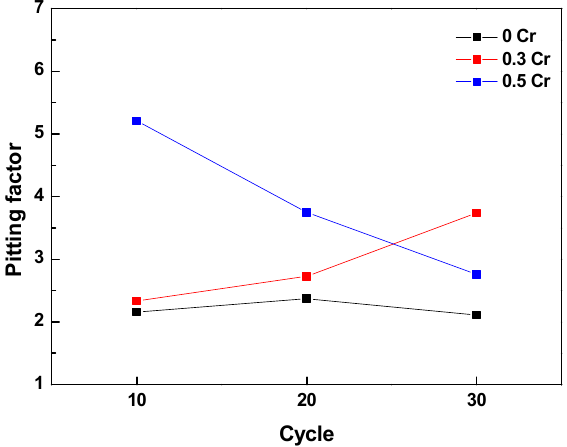
Figure 7. Variation of pitting factor according to CCT cycle.